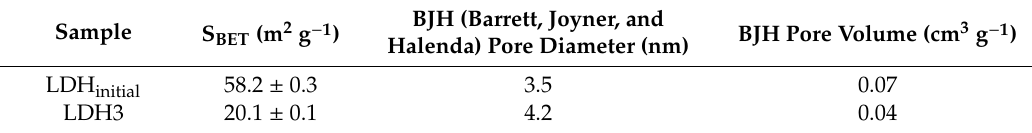
Table 7. Specific surface area (S BET ) and pore characteristics of Mg 2 Al-CO 3 LDH synthesised from reactors 1 and